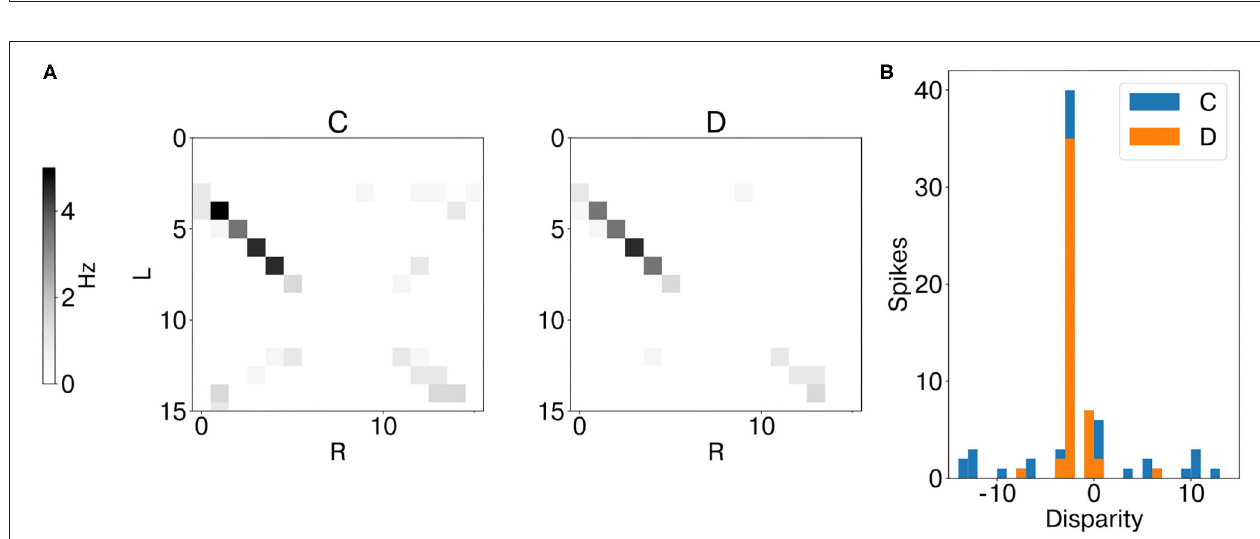
FIGURE 8 | Performance sensitivity to the stimulus speed: PCM (bottom graph, with median and interquartile range, measured across one trial over time windows t i = 300 ms), TTA, and FTA (top graph). As the stimulus speed increases, the stereo matching performance increases (i.e., lower FTA).